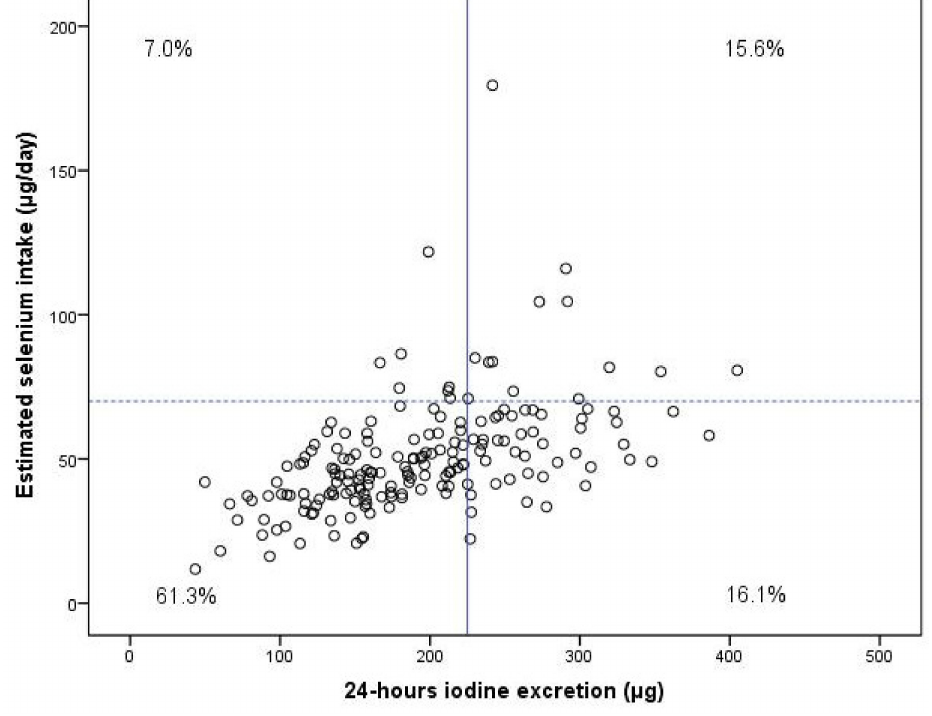
Figure 3. Estimated selenium intake ( µ g/day) in relation to 24 h urine iodine excretion ( µ g). The horizontal line ( ···· ) depicts the 60 µ g/day RDA (IOM, Nordic) for pregnant women, and the vertical line (|) depicts the 225 µ g cut-off value for 24 h urine iodine